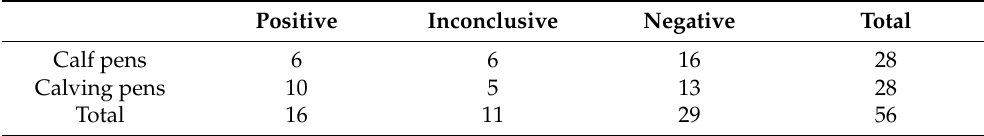
Table 2. Distribution of pooled PCR results for pre-weaned calf pens and calving pens.